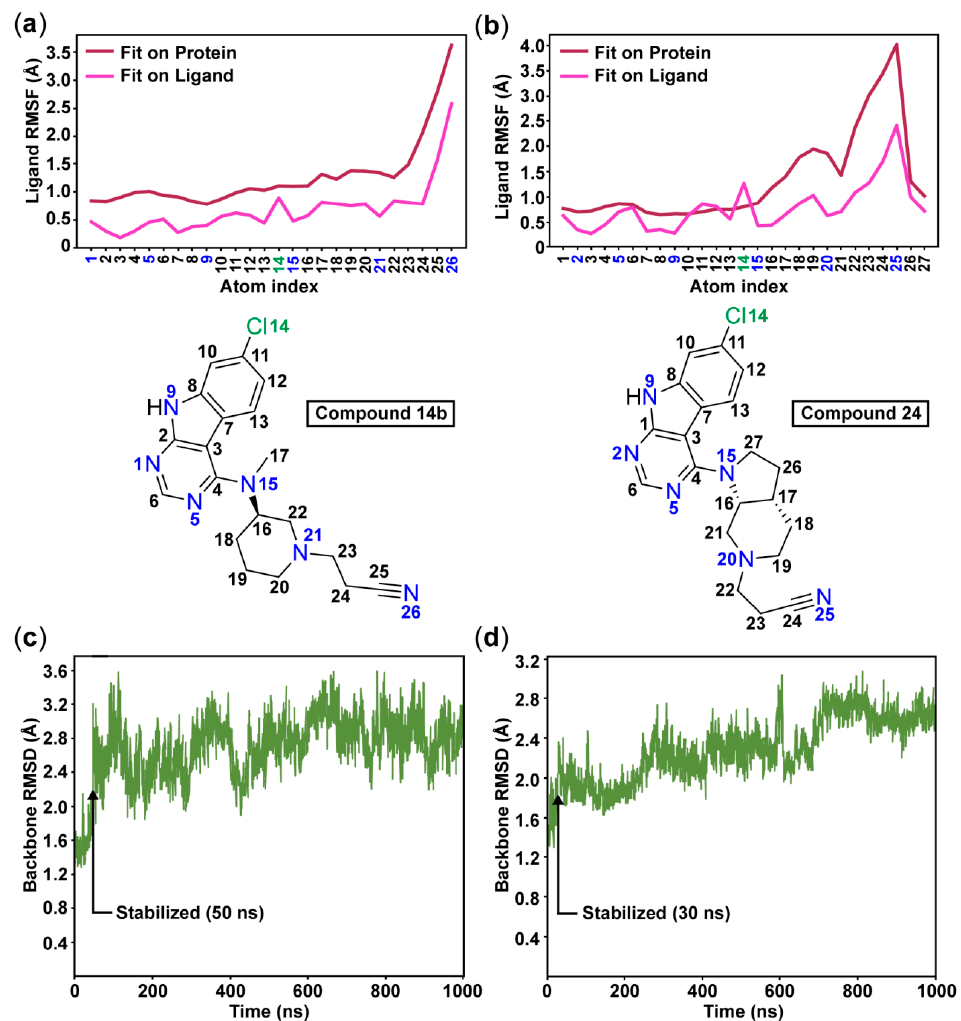
Figure 3. The root-mean-square fluctuations (RMSF) of the ligands 14b ( a ) and 24 ( b ) illustrate the high flexibility of the cyanoethyl moieties throughout the simulations. The root-mean-square deviation (RMSD) of the protein shows that the simulations stabilize after 50 ns with compound 14b ( c ) and after 30 ns with compound 24 ( d ).